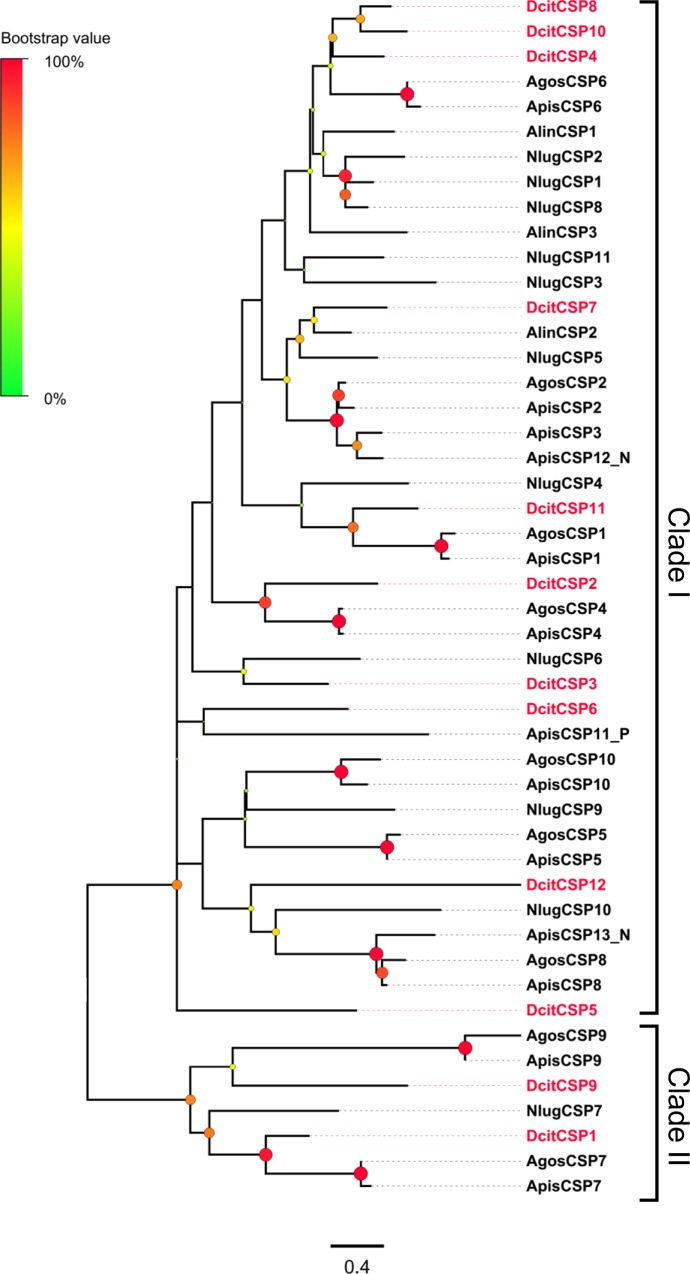
Phylogenetic relationship between DictCSPs.